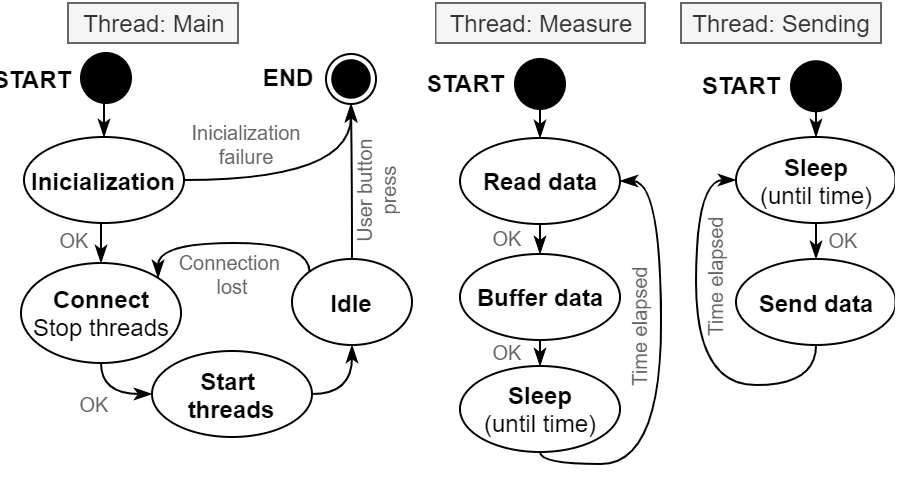
Figure 4. State diagram of the proposed measurement